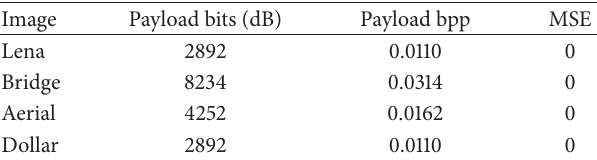
Table 1: Payload bits and